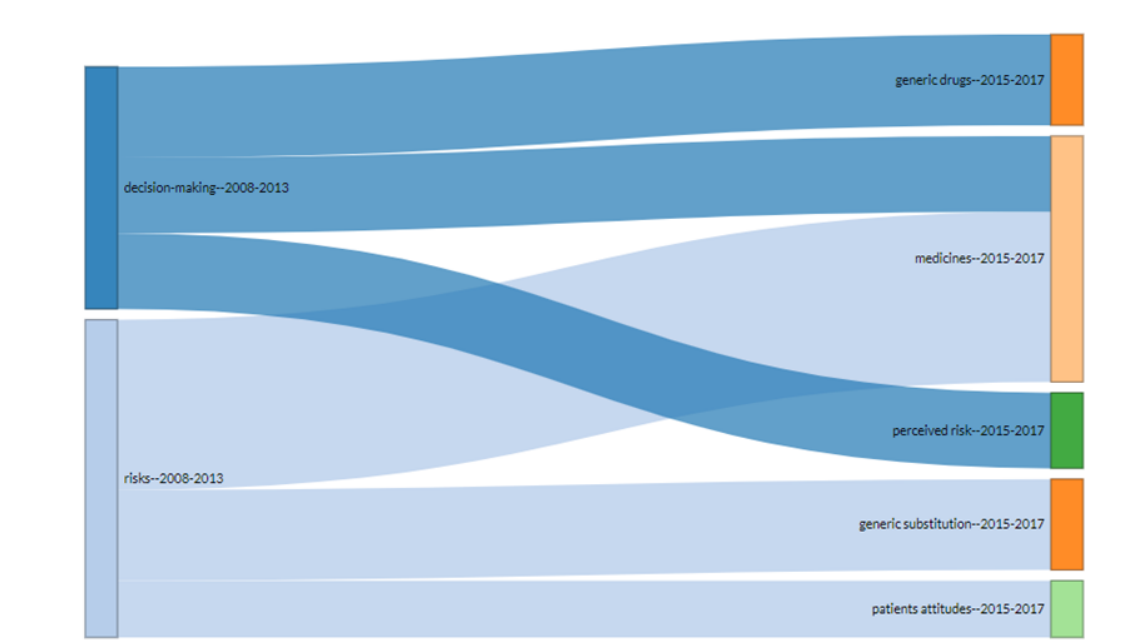
Figure 6. Thematic evolution of the research.